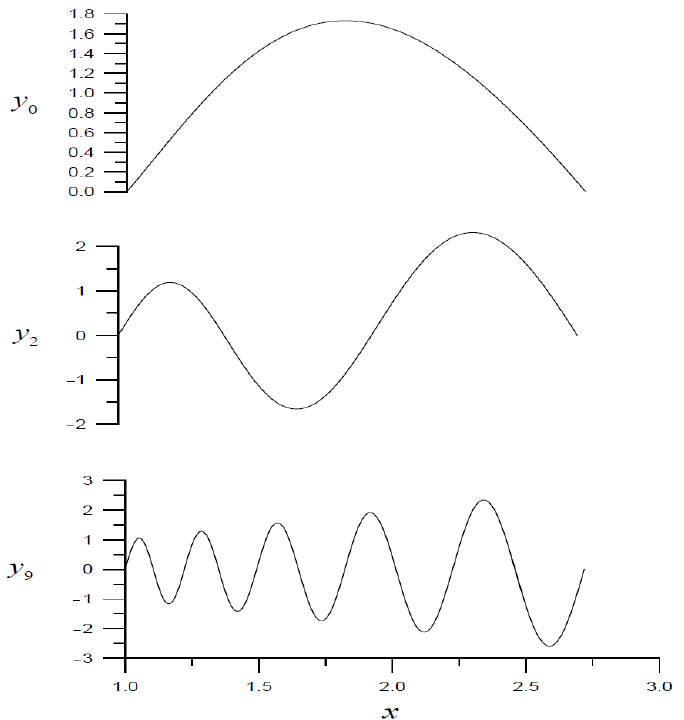
Figure 2. Numerical solutions of the eigenfunctions for Example 1.